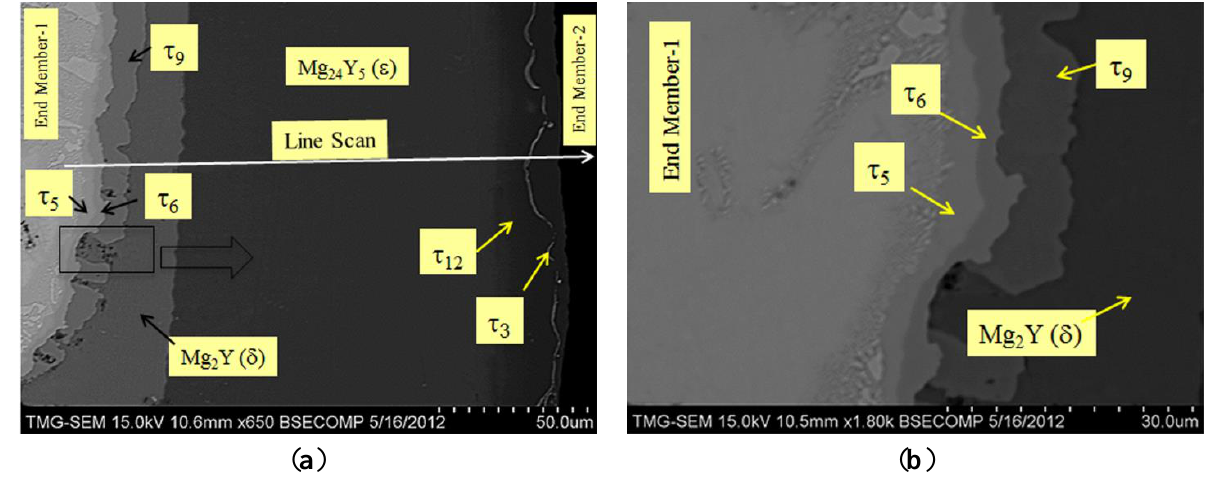
Figure 3. ( a ) Solid-solid diffusion couple of Mg–sample 20 (18.5/22.4/59.1 Mg/Ni/Y at%) annealed at 673 K for 4 weeks; ( b ) Magnified area of interest.